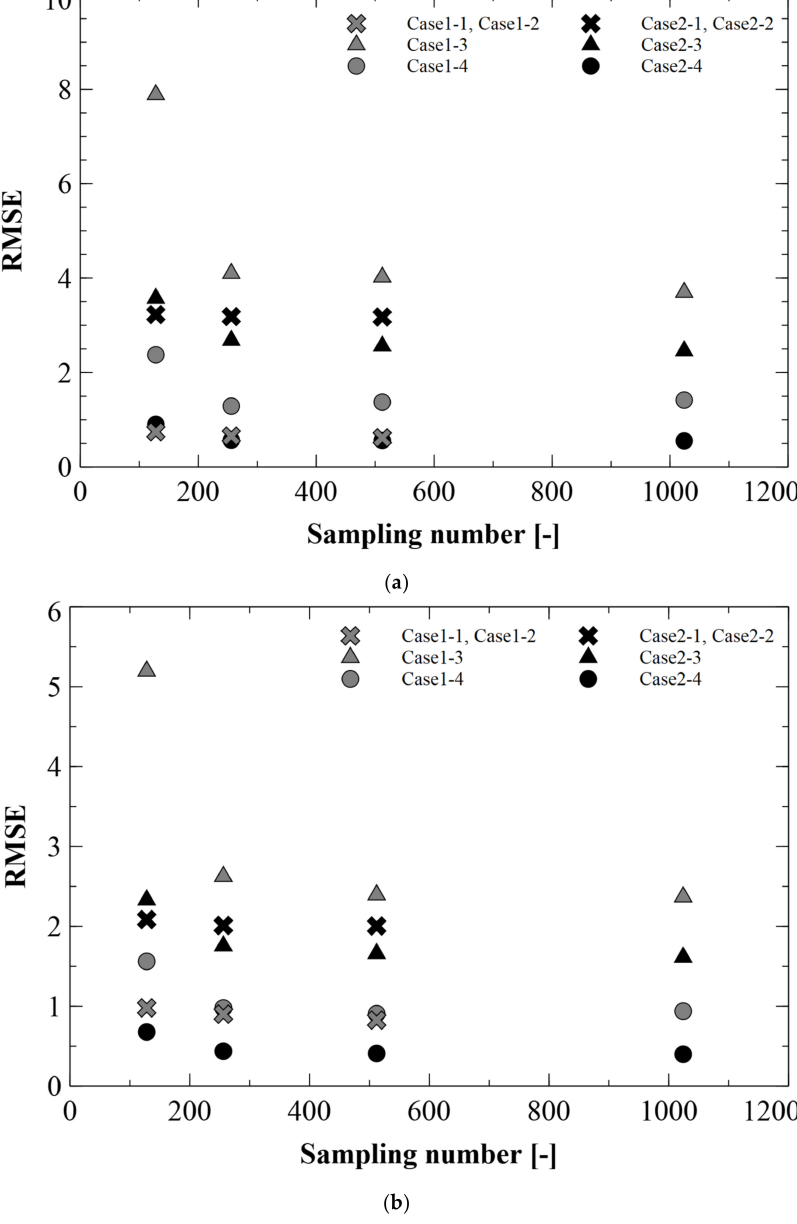
Figure 4. ( a ) Comparison of meta-model accuracies for heating load (RMSE). ( b ) Comparison of meta-model accuracies for cooling load